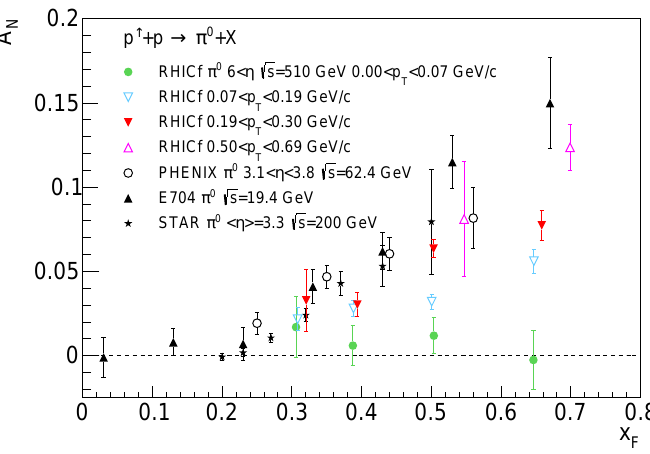
Figure 4: Comparison of the RHICf data with the previously measured A forward π 0 s as a function of x